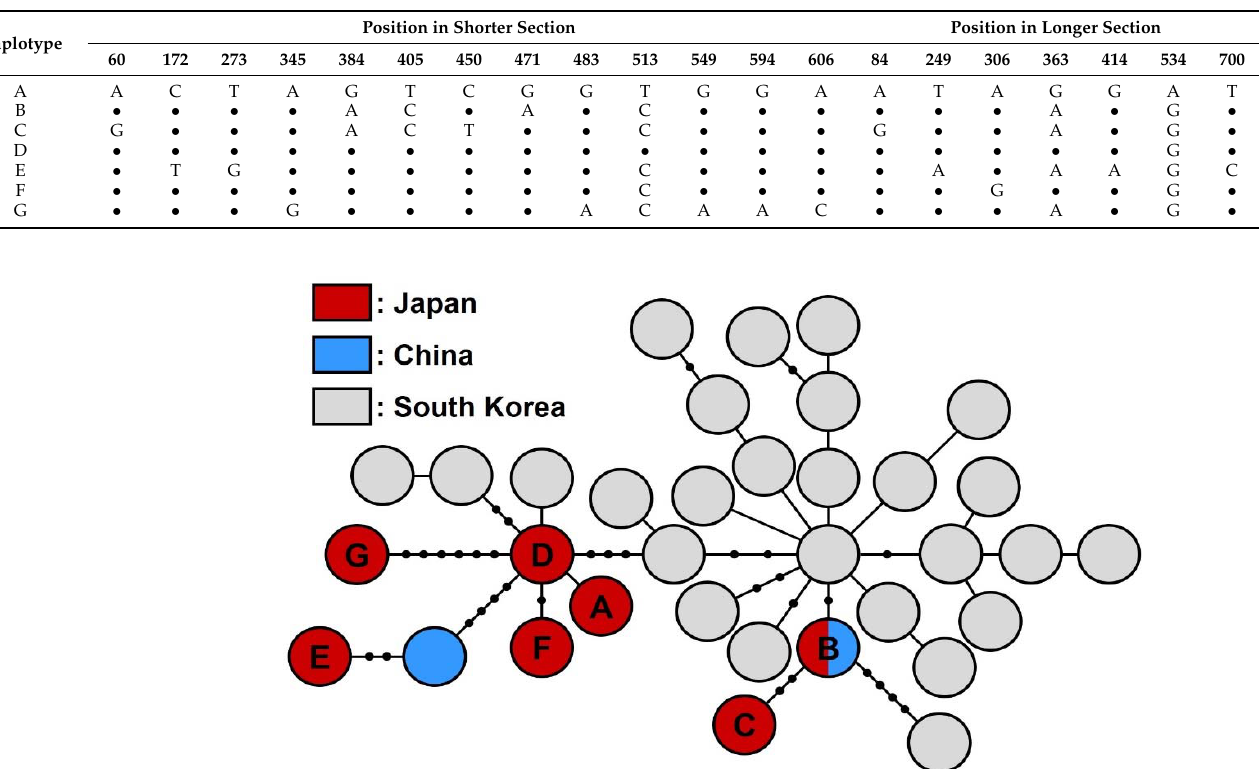
Table 2. Nucleotide substitution sites in mitochondrial CO1 regions of Aromia bungii among the haplotypes detected in the present study. The shorter section was determined with the primer pair LCO1490 and HCO2198. The longer section was determined with the primer pair CO1 ‐ Corz and tRNA Leu ‐ R.